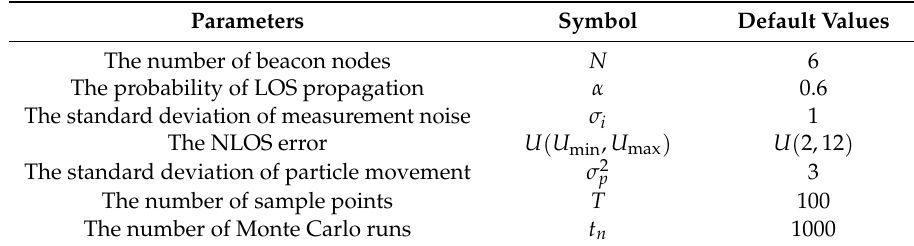
Table 3. The default parameter values.